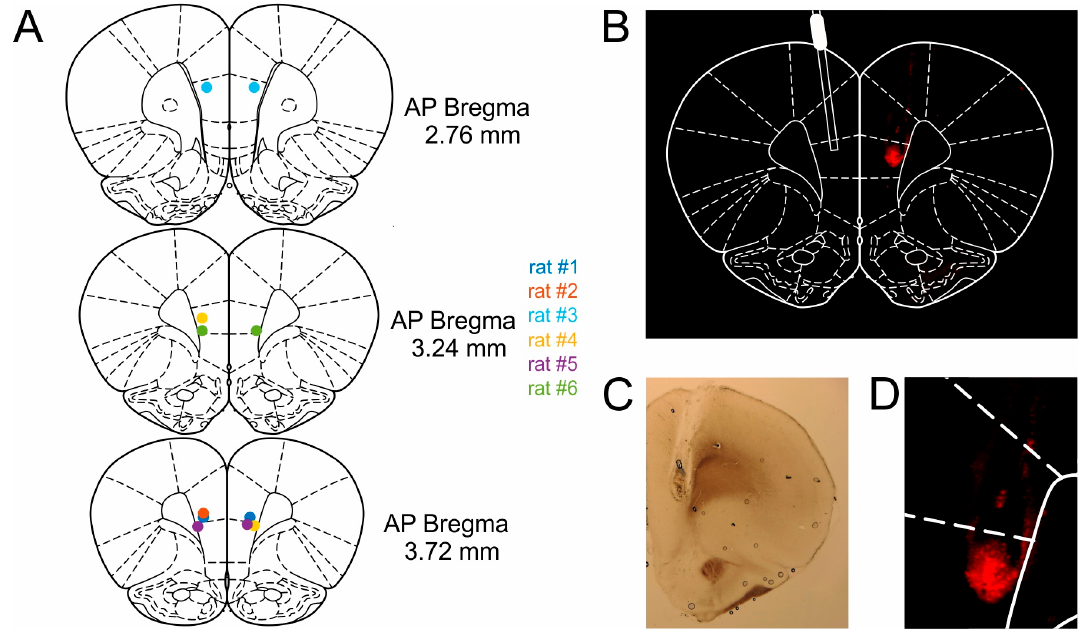
Figure 7. Bilateral microinfusion sites in the mPFC. ( A ) Cannula locations in mPFC, colored dots represent cannula tips of individual rats. Brain diagrams adapted from Reference [66]. ( B ) Coronal slice of the right hemisphere with Evans Blue fluorescence region (right) and schematic representation of the guide cannula (left). The fluorescence is restricted to the prelimbic portion of mPFC. ( C ) Image of a coronal slice under bright field illumination. ( D ) Magnified image of the Evans Blue spread shown in ( B ).